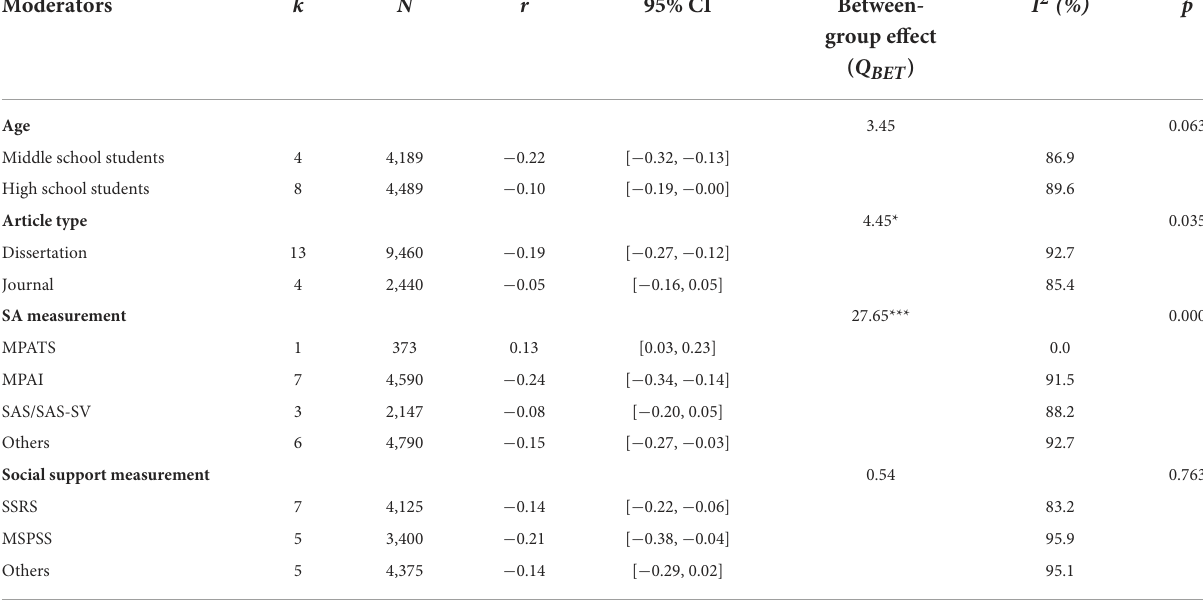
TABLE 6 Subgroup analyses of the summary correlation between smartphone addiction and social